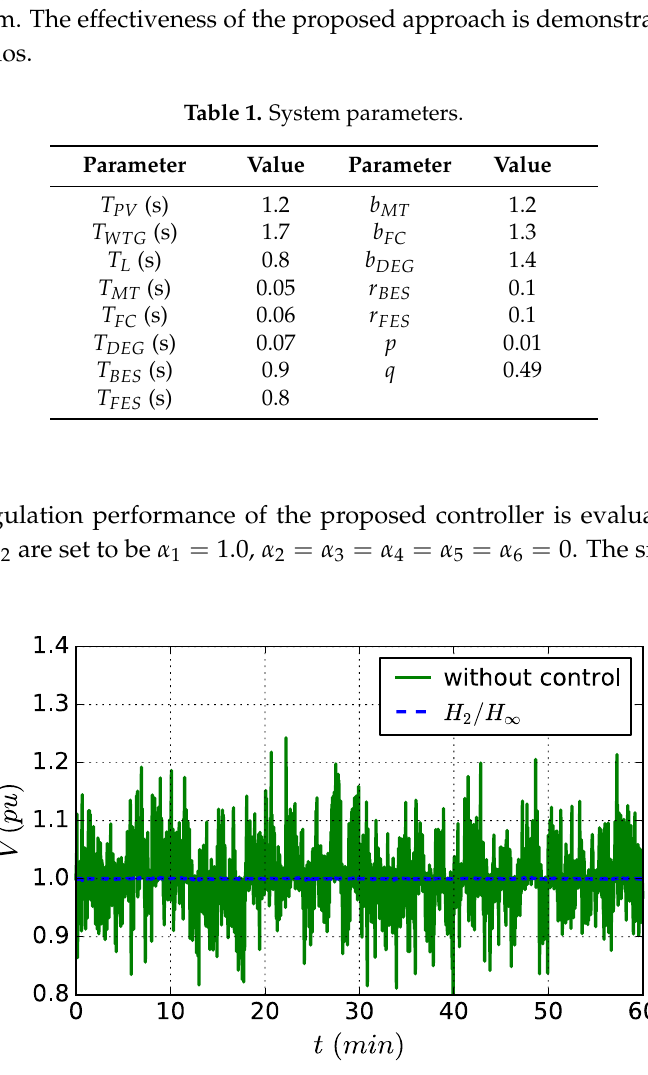
Figure 3. Dynamics of the DC bus voltage deviation.